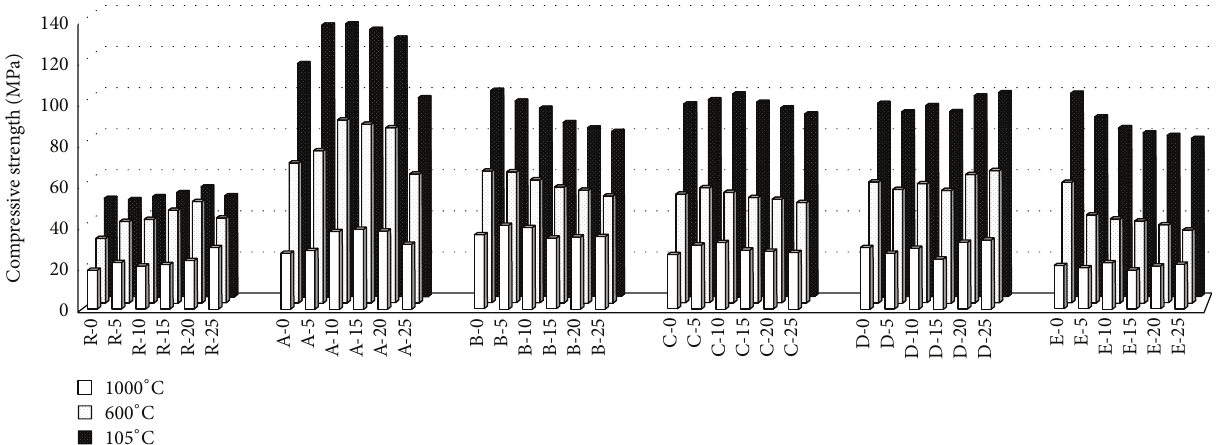
Figure 6: Impact of different composition and temperature loading on compressive